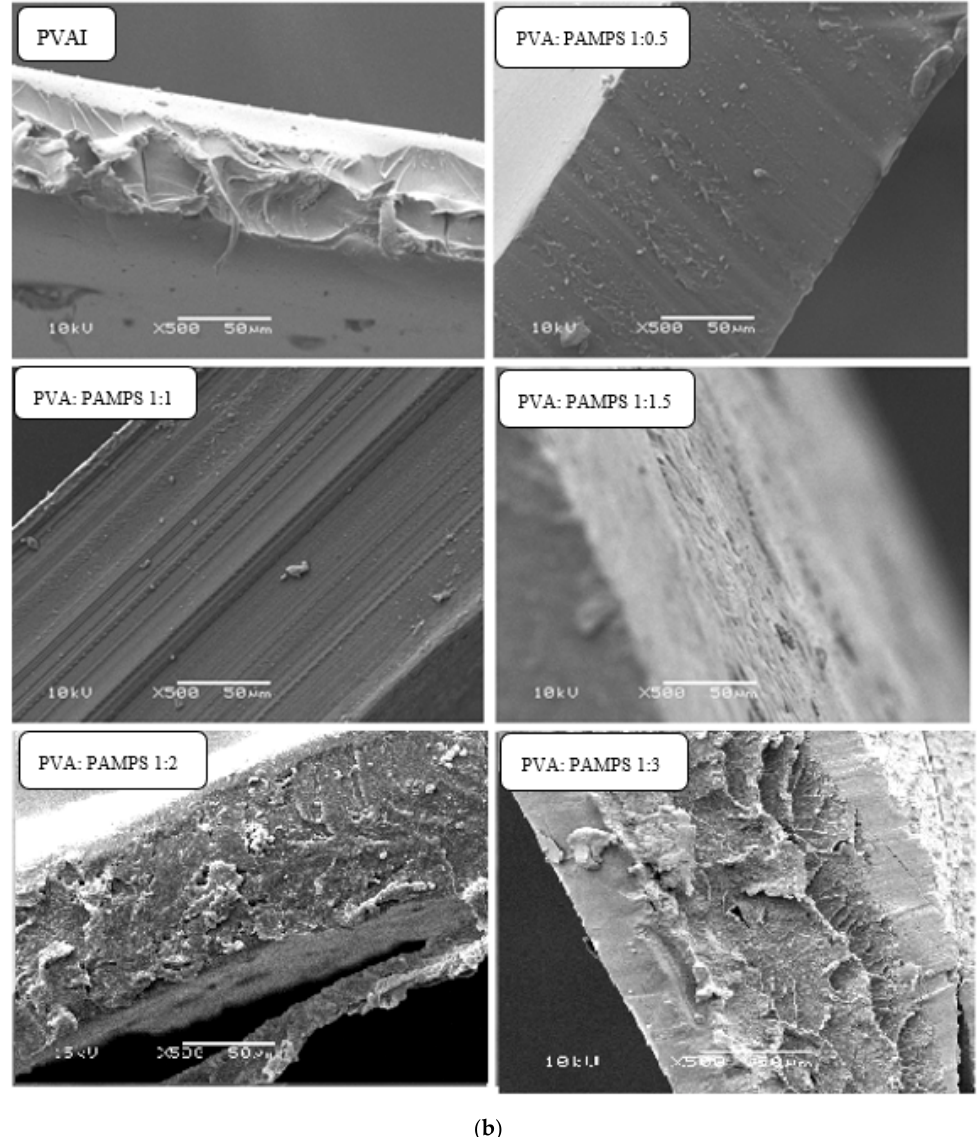
Figure 2. ( a ): SEM micrographs of surface of pristine PVA and PVA/PAMPS blend-based membranes at magnification power of 500 × . ( b ): SEM micrographs of cross-section of pristine PVA and PVA/PAMPS blend-based membranes at magnification power of 500 × .